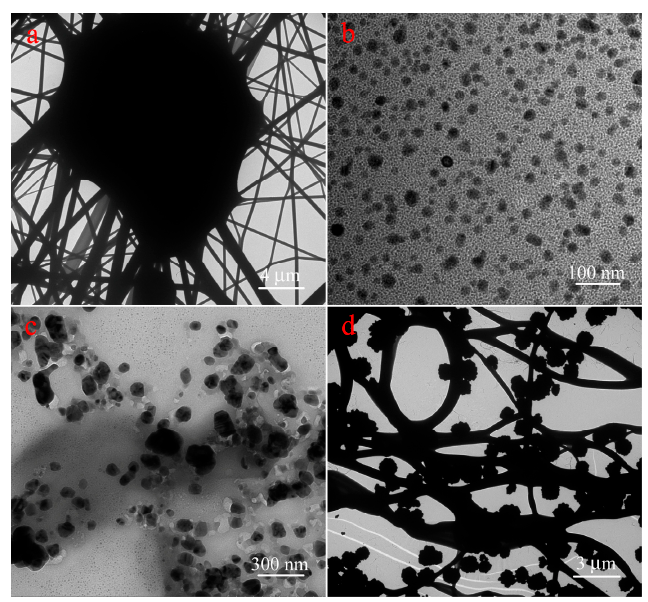
Figure 3. TEM images of the prepared PVA/PAA/GO-COOH nanocomposite ( a ); the obtained Ag nanoparticles at 5 min ( b ) and 1 h ( c ); and PVA/PAA/GO-COOH@AgNPs nanocomposite at a modified time of 1 h ( d ).